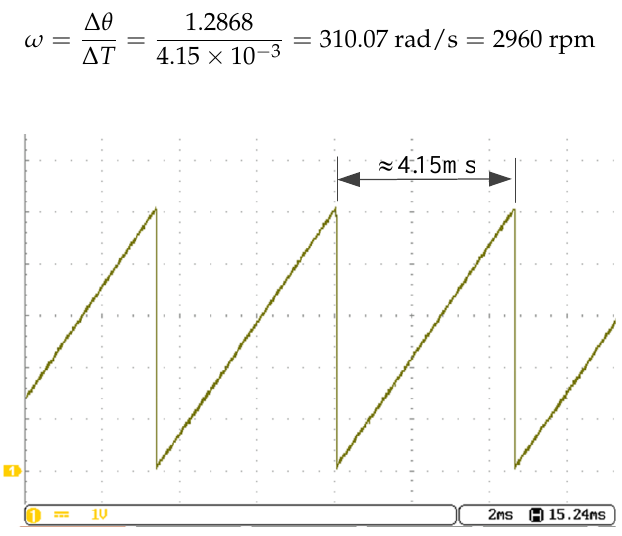
Figure 18. The position responses for the speed command of 3000 rpm.